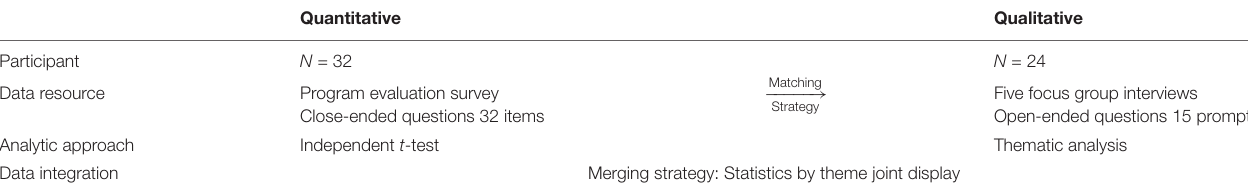
TABLE 1 | Convergent mixed methods design